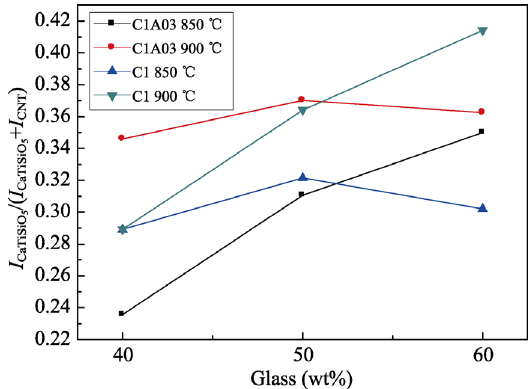
Fig. 3 Variation in the amount of sphene for the Ca 0.7 Nd 0.2 TiO 3 added with various amounts of C1 and C1A03 glasses and sintered at 850 and 900 ℃ .